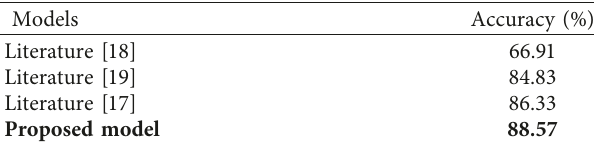
Table 3: Grade evaluation